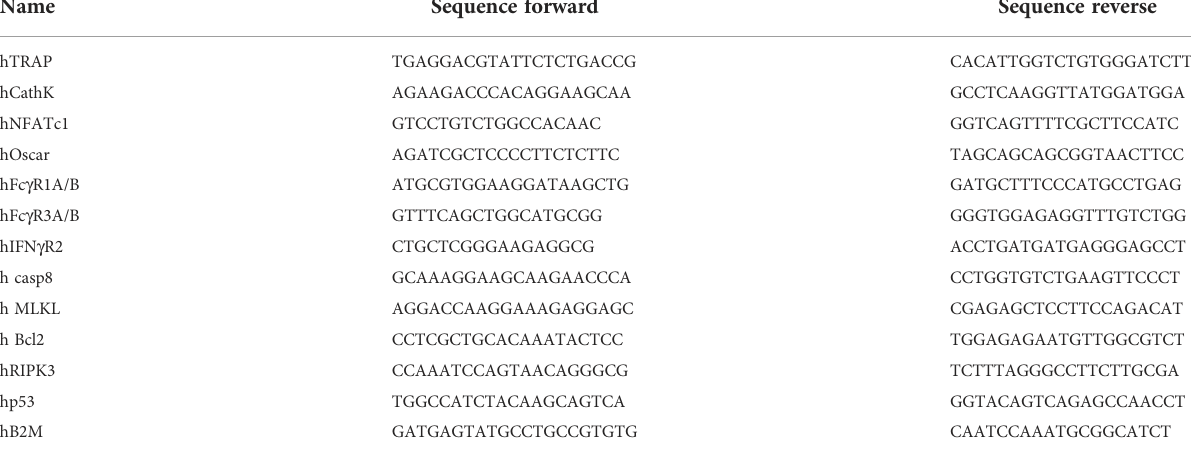
TABLE 1 Primer sequences for real-time